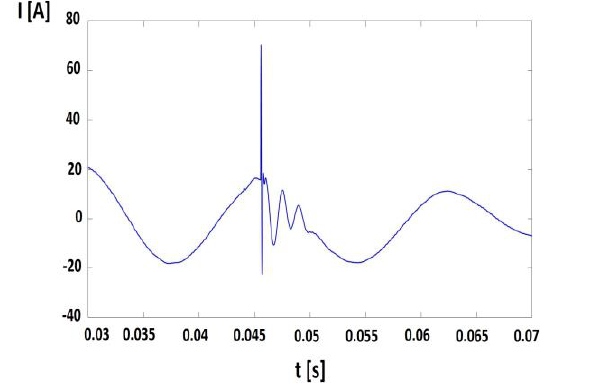
Fig. 1. Model of a tested photovoltaic installation.